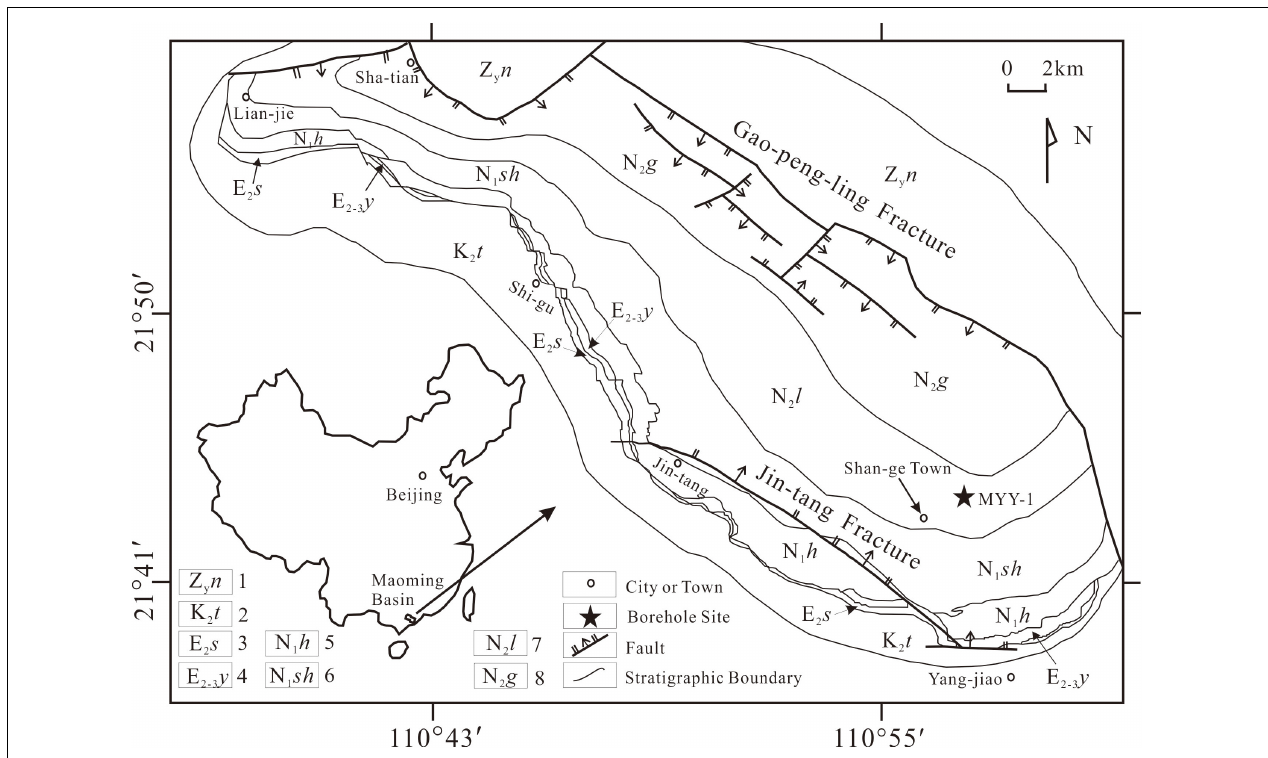
FIGURE 1 | Geographical and sampling corehole locations and geological setting of Maoming